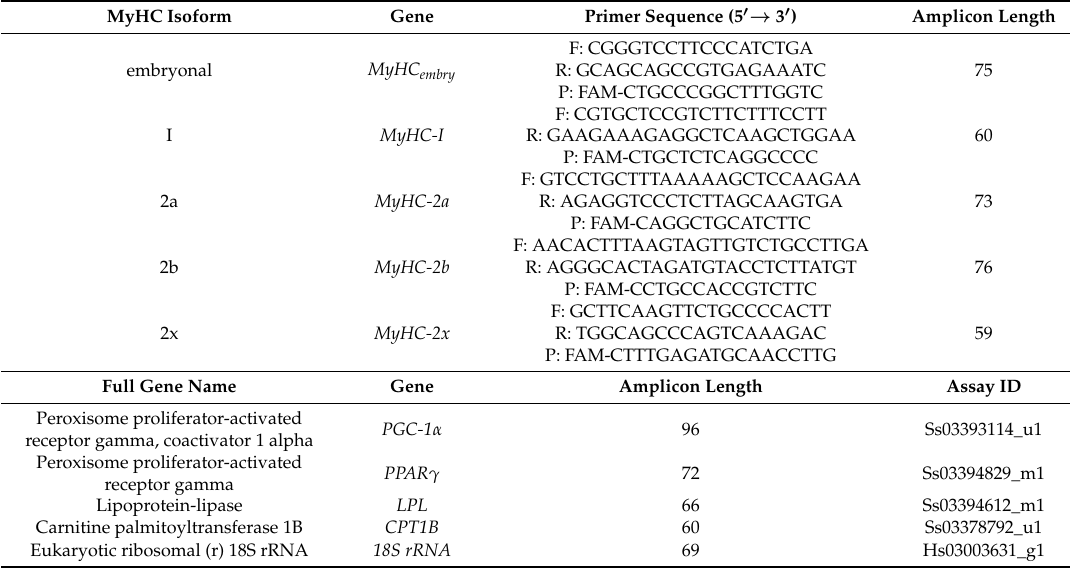
Table 1. Information on the primers and predeveloped assays used for